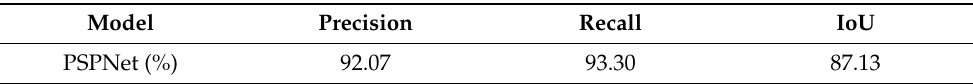
Figure 8. A qualitative example of building façade segmentation by the pre-trained PSPNet model. ( a ) Original street view image. ( b ) Ground truth. ( c ) Building semantic segmentation by PSPNet. ( d ) Qualitative example, blue is true positive (TP), red is false negative (FN), and blue is false positive (FP). Table 3. Building façade segmentation performance on street-level